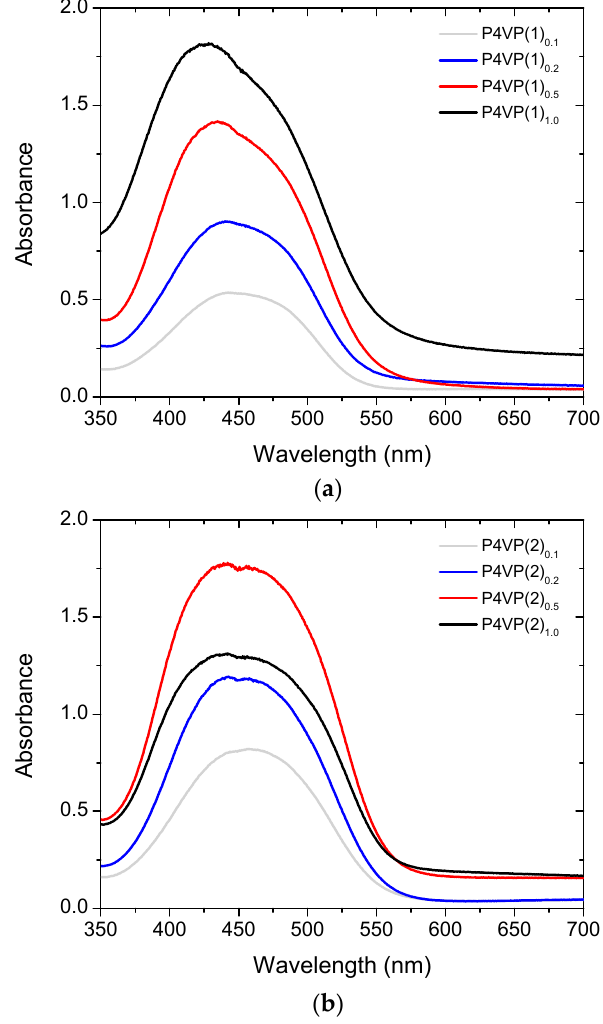
Figure 3. Absorption spectra of thin films of halogen-bonded ( a ) P4VP( 1 ) x and ( b ) P4VP( 2 ) x complexes with complexation degree x = 0.1, 0.2, 0.5, and 1.0. The data has been normalized to match with a thickness of 400 nm.